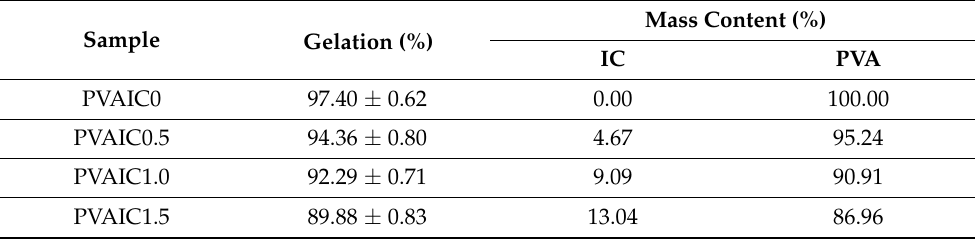
Table 1. Gelation value and mass content of PVA hydrogels containing various amounts of quercetin/HP- β -CD inclusion complex. Data shown as mean ± standard deviation ( n = 5). IC as quercetin/HP- β -CD inclusion